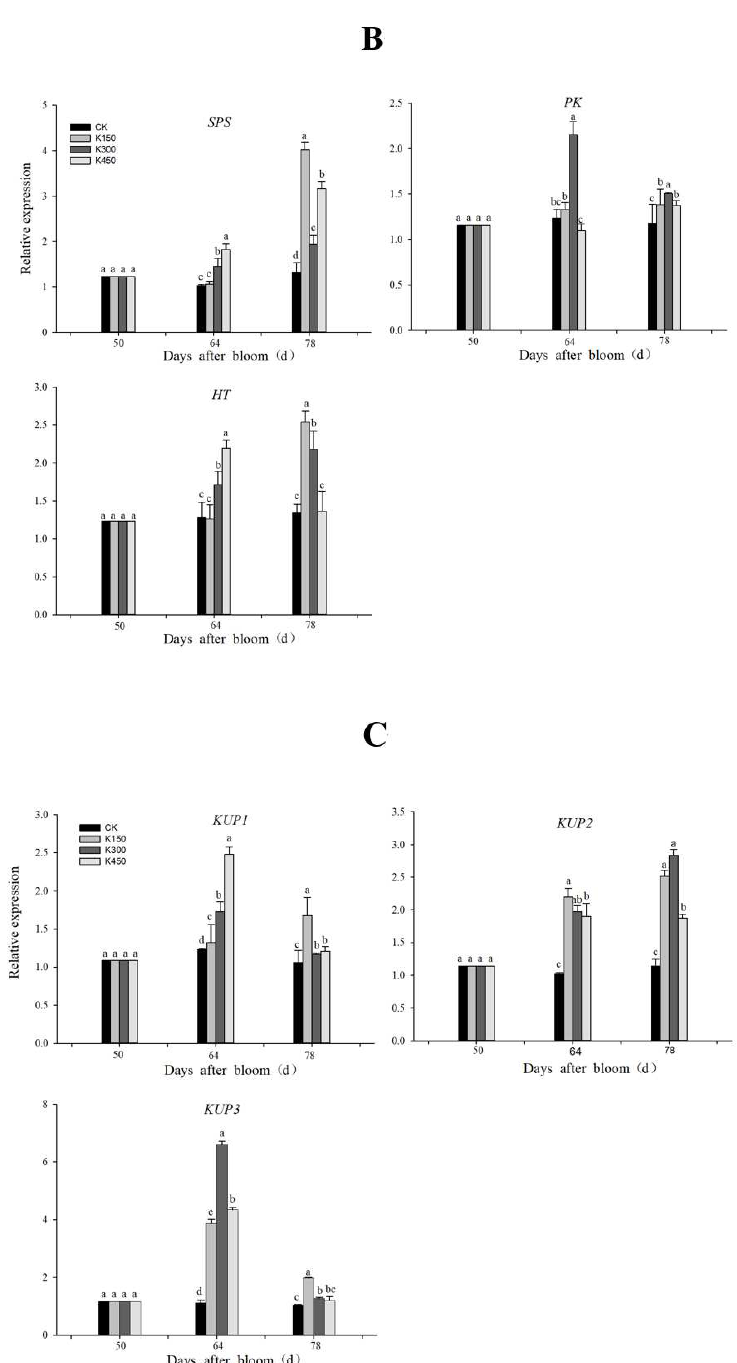
Figure 11. Comparison of expression profiles of representative genes detected by RT-qPCR, different letters (abcd) indicate the difference is significant (Duncan’s Multiple Range Test, p < 0.05). The column represents the expression detected by RT-qPCR. ( A ): Relative expression levels of anthocyanin-related genes; ( B ): relative expression levels of sugar-related genes; ( C ): relative expression levels of potassium-related